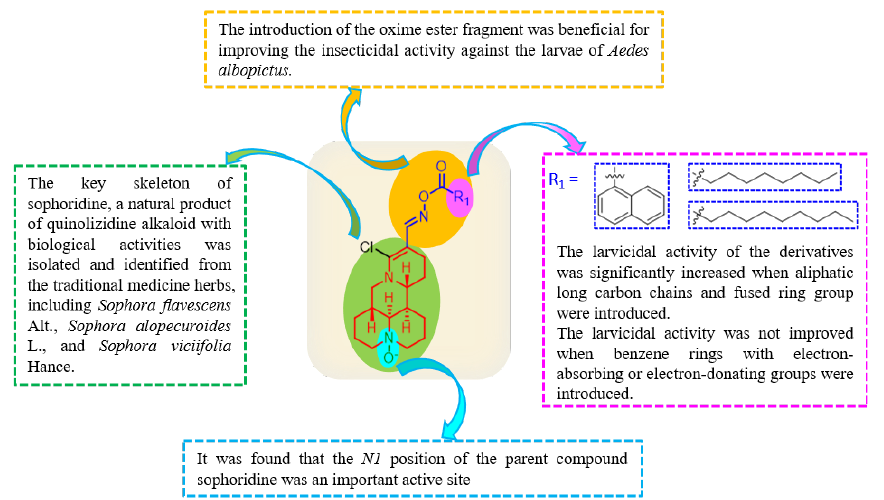
Figure 4. The structure–activity relationships of sophoridine derivatives.